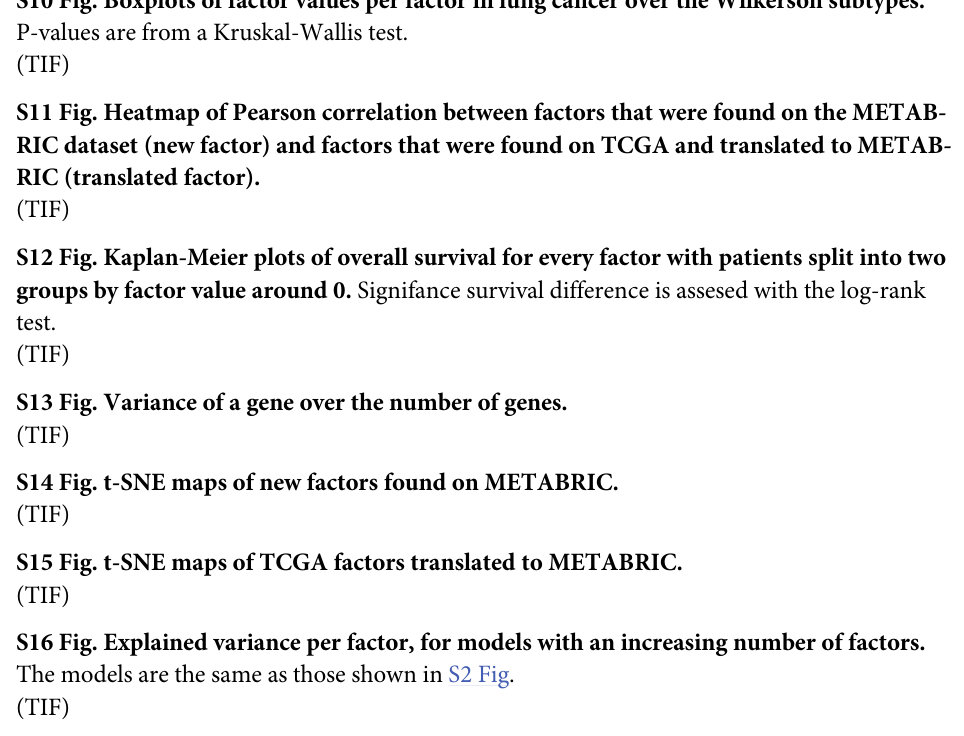
S2 Fig. Correlation between the factors of the best solution with a number of factors and the best solution with one factor more. (TIF) S3 Fig. Histograms of factor values. (TIF) S4 Fig. Heatmap of GSEA normalized enrichment statistic (breast). (TIF) S5 Fig. Heatmap of GSEA normalized enrichment statistic (lung). (TIF) (TIF) (TIF) S8 Fig. Scatterplot of coefficients and values of RPPA technical factors in lung. (TIF) S9 Fig. Boxplots of factors values per factor in breast cancer over the PAM50 subtypes. P-values are from a Kruskal-Wallis test. (TIF) S10 Fig. Boxplots of factor values per factor in lung cancer over the Wilkerson subtypes. P-values are from a Kruskal-Wallis test. (TIF) S11 Fig. Heatmap of Pearson correlation between factors that were found on the METAB- RIC dataset (new factor) and factors that were found on TCGA and translated to METAB- RIC (translated factor). (TIF) S12 Fig. Kaplan-Meier plots of overall survival for every factor with patients split into two groups by factor value around 0. Signifance survival difference is assesed with the log-rank test. (TIF) S13 Fig. Variance of a gene over the number of genes. S14 Fig. t-SNE maps of new factors found on METABRIC. (TIF) S15 Fig. t-SNE maps of TCGA factors translated to METABRIC. (TIF) S16 Fig. Explained variance per factor, for models with an increasing number of factors. The models are the same as those shown in S2 Fig.